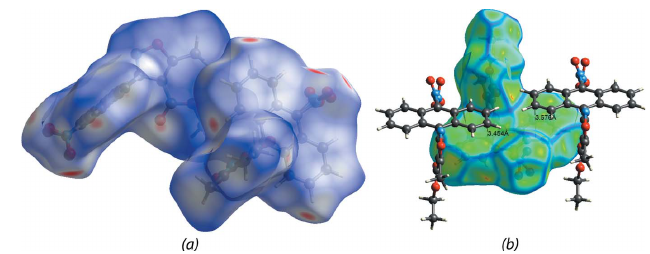
Figure 6 ( a ) The Hirshfeld surface of (I) mapped over d norm . Short and long contacts are indicated as red and blue spots, respectively. Contacts with distances approximately equal to the sum of the van der Waals radii are colored white. ( b ) Weak (cid:3) – (cid:3) interactions are shown as green dashed lines on a surface mapped over curvedness. The (cid:3) – (cid:3) stacking is indicated by the green flat regions surrounded by dark blue